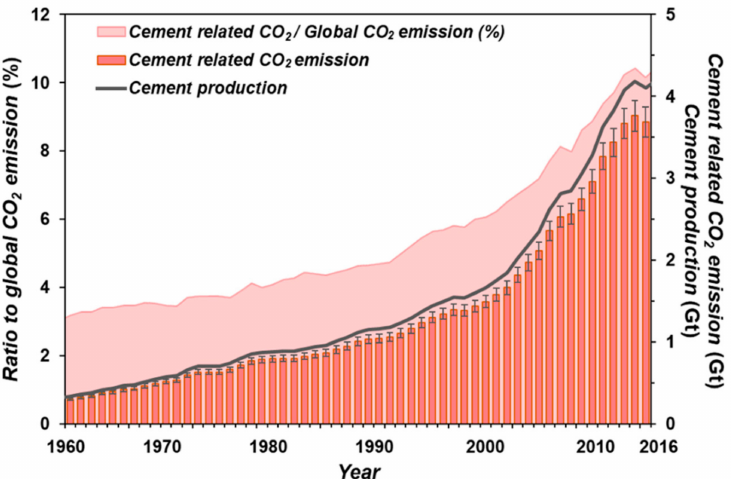
Figure 9. CO 2 emissions related to the production of cement and its ratio to total CO 2 emissions. Reproduced with permission from Thomas D. Kelly and Grecia R. Matos, Historical statistics for mineral and material commodities in the U.S.; published by the United States Geological Survey (USGS), 2015